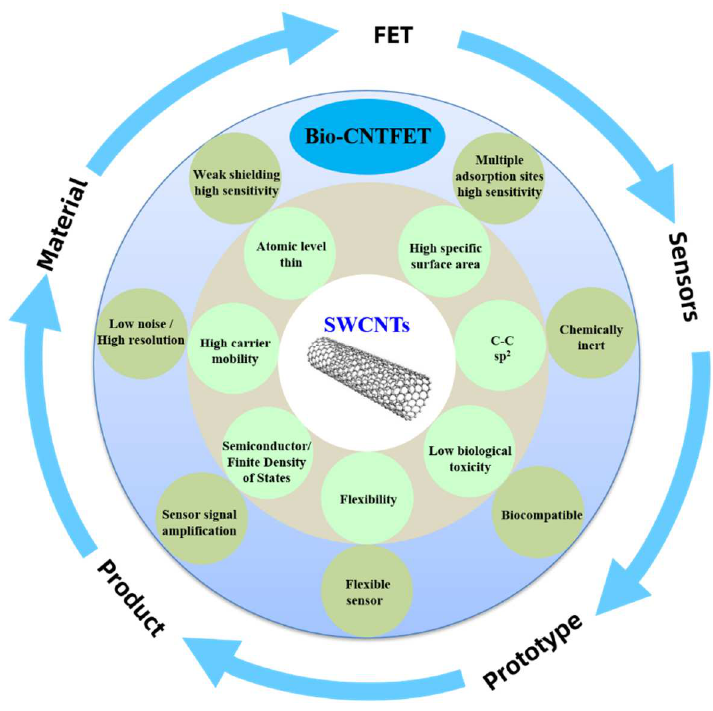
Figure 2. The advantages of using single-walled carbon nanotubes in sensors.